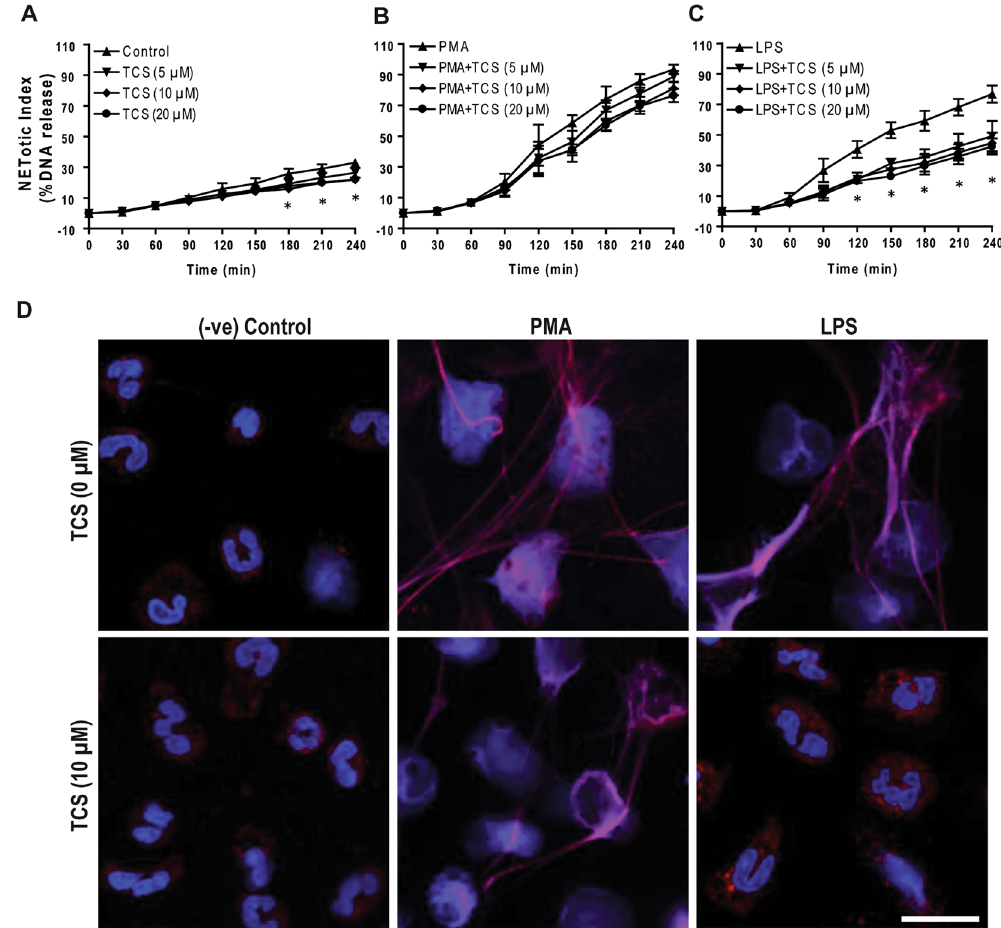
Figure 5. JNK inhibition by TCSJNK6o suppresses LPS-mediated NETosis. ( A–C ) NETosis kinetics was assessed by Sytox Green plate reader assay after activation with 25 nM PMA and 25 μ g/ml LPS in the presence or absence of TCSJNK6o. As shown in the %DNA release analysis, TCSJNK6o (TCS; 5, 10, 20 μ M) suppresses LPS mediated NETosis, while not in PMA mediated NETosis (n = 3–4; * p value < 0.05; Two-way ANOVA with Bonferroni’s post test conducted at each time point). Error bars in all the panels represent SEM. ( D ) Neutrophils were activated by PMA and LPS with and without TCSJNK6o for 4 hours, immunostained, and imaged for myeloperoxidase (MPO) and DNA. MPO is visible around the nuclei in media control with or without TCSJNK6o. MPO co-localizes to NET DNA generated by LPS, PMA, and PMA with TCSJNK6o. Treating neutrophils with LPS in the presence of TCSJNK6o does not result in NETosis, and the nuclear morphology of these cells remains the same as that of the unstimulated control neutrophils (Blue, DAPI staining for DNA; Red, MPO; n = 3; scale bar 20 μ m). See Supplementary Fig. S5 for low magnification